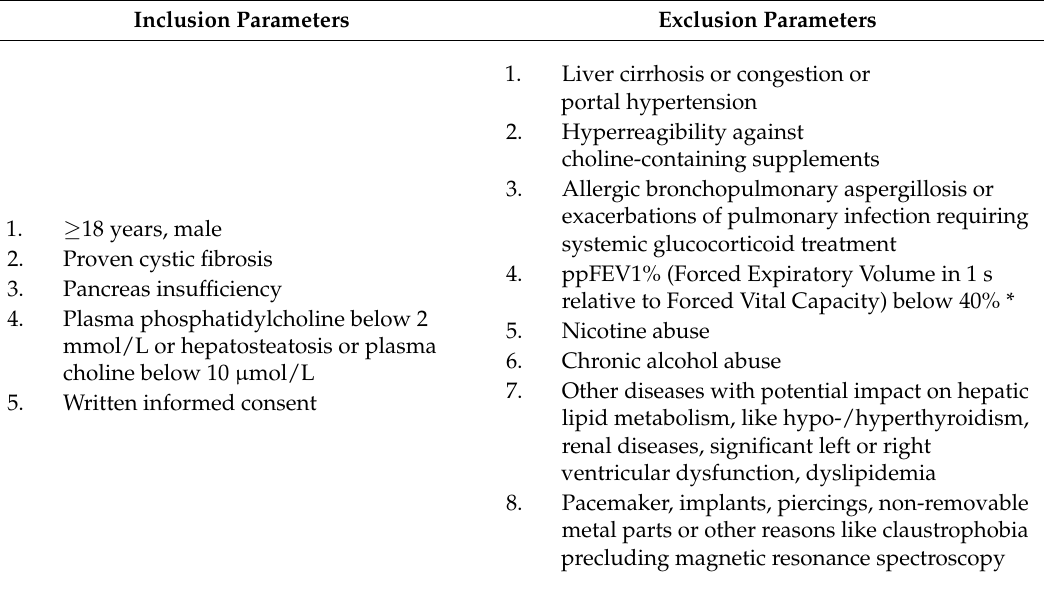
Table A1. Parameters of Phos CF-II patients.